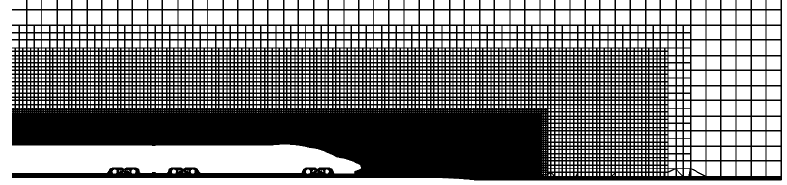
Figure 9. The grids on the longitudinal section of wake region.